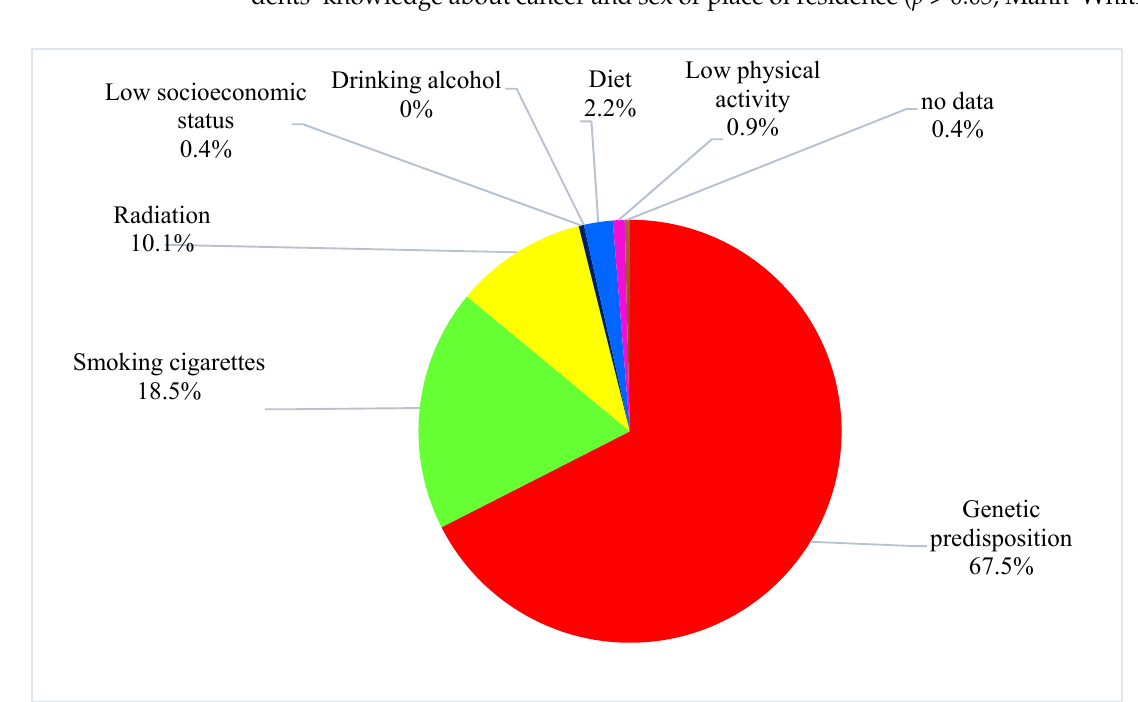
Figure 1. The students’ opinion about the most important cancer risk factor.